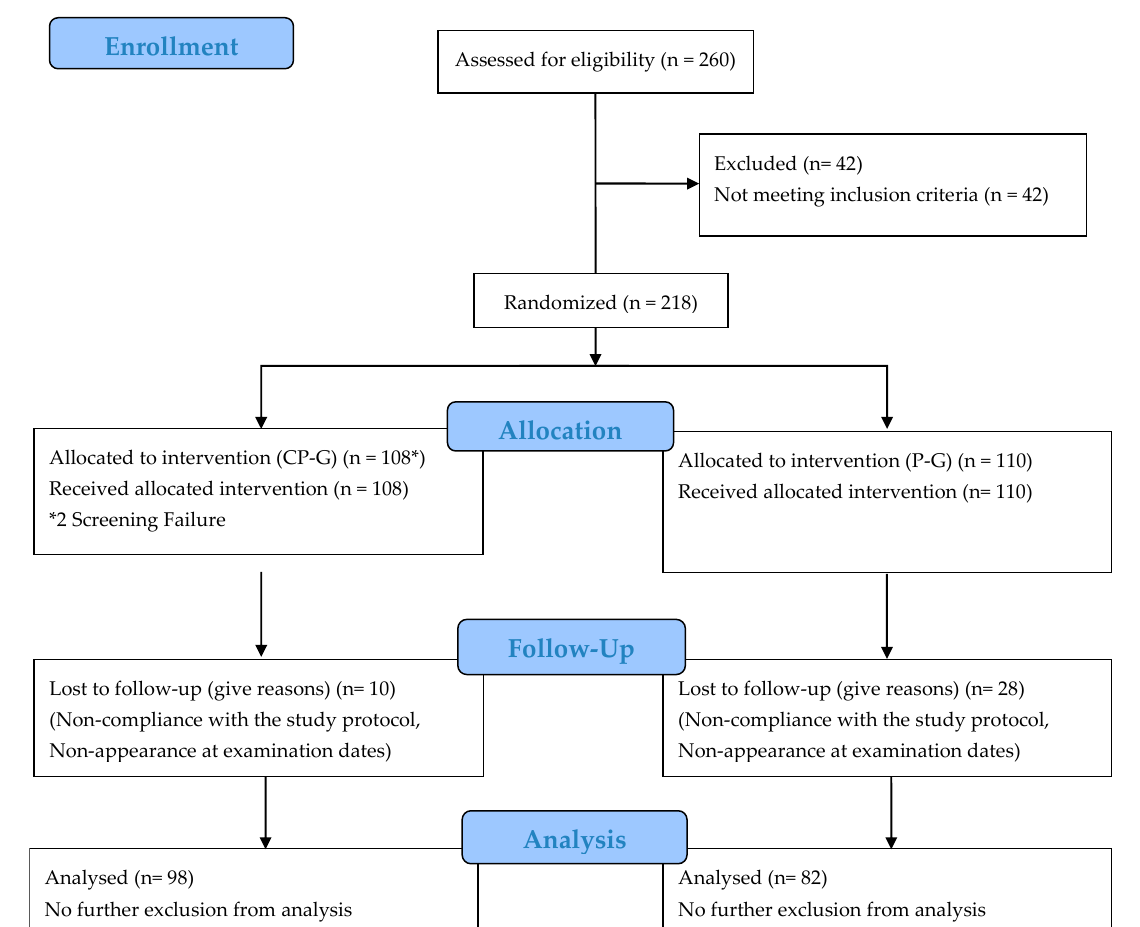
Figure 1. Flow chart of subject recruitment, randomization and follow up.